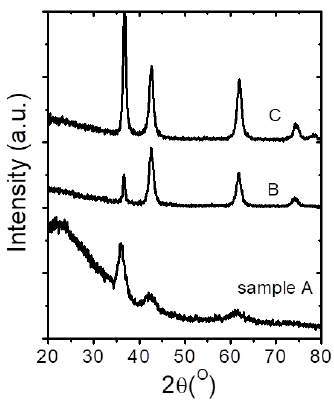
Figure 2. X-ray di ff raction (XRD) measured in Samples A, B, and C, grown on glass substrates. The four Figure 2. X-ray diffraction (XRD) measured in Samples A, B, and C, grown on glass substrates. The peaks are 36.8 ◦ (111), 42.7 ◦ (200), 61.9 ◦ (220), and 74.5 ◦ (311). Y-axis scale is the same, and zeros are four peaks are 36.8° (111), 42.7° (200), 61.9° (220), and 74.5° (311). Y-axis scale is the same, and zeros shifted for clarity. are shifted for clarity.